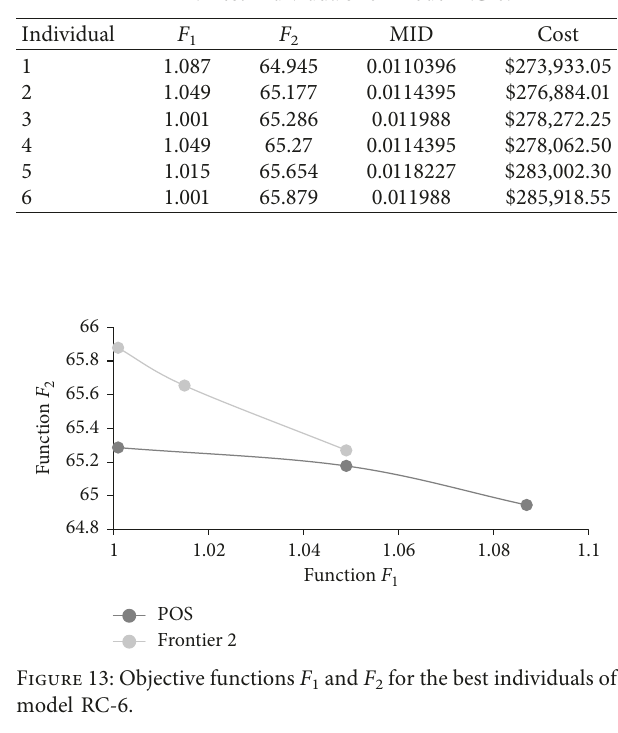
Figure 11: Optimal beam and column sections from individual 1, model RC-3.